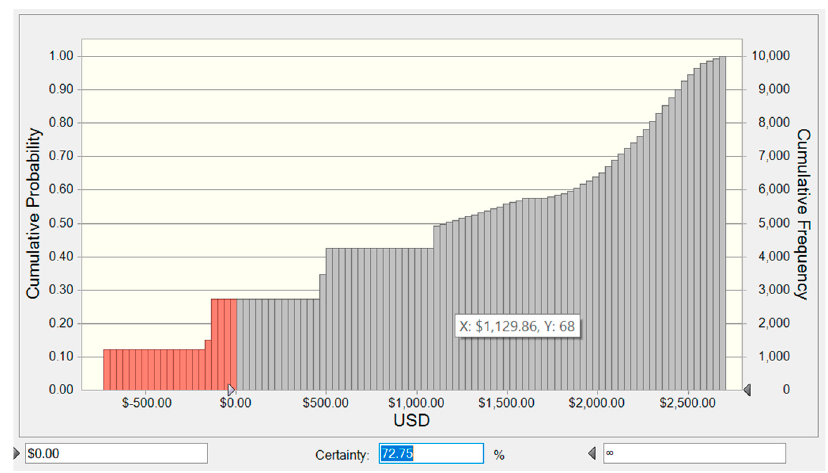
Figure 7. Stochastic results of NPV in the SE region.